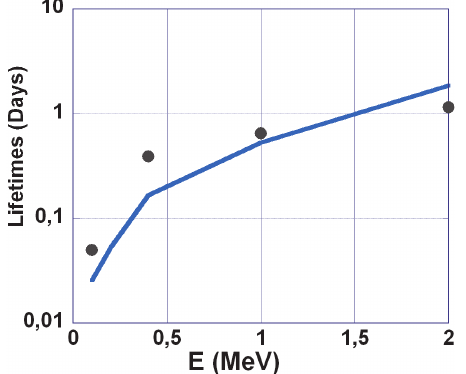
Fig. 18. Comparison of analytical lifetime with parameterized life- times obtained by fitting numerical simulations for (cid:127) pe /(cid:127) c0 = 4 . 5 at L = 4 . 5 as a function of energy on the dayside. The analytical estimate in Eq. (9) is plotted (blue line for 100pT average intensity lower-band chorus with ω m /(cid:127) c0 ∼ 0 . 3) as well as the parameter- ized lifetime (solid black circles) for moderately oblique waves.